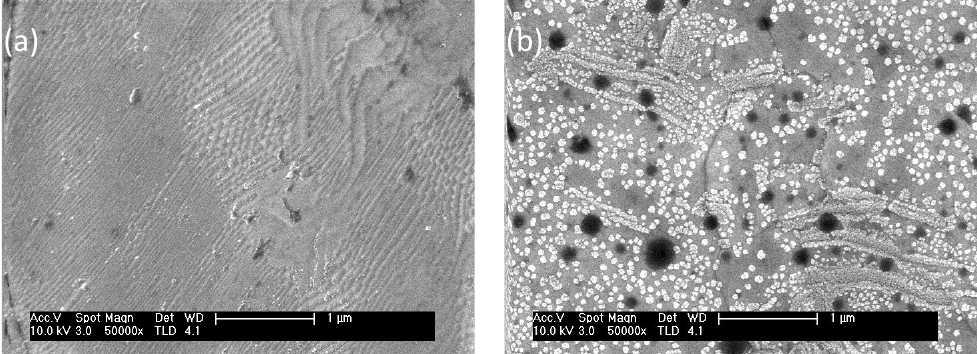
Figure 3. UHRSEM micrograph of ( a ) a FPP modified platinum wire electrode and ( b ) PtNPs electrodeposited on the FPP film as template.